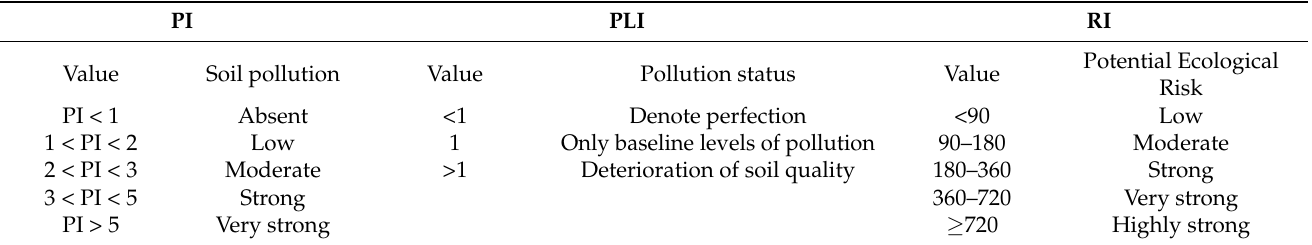
Table 2. Evaluation scales of used indexes